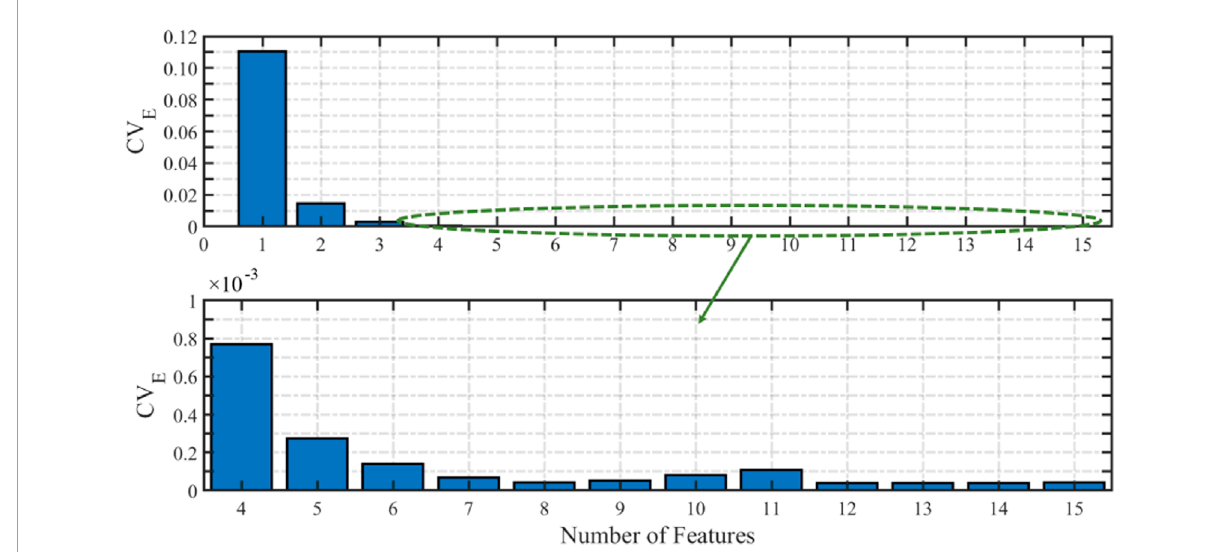
FIGURE 3 Cross-validation error for the number of features included in the